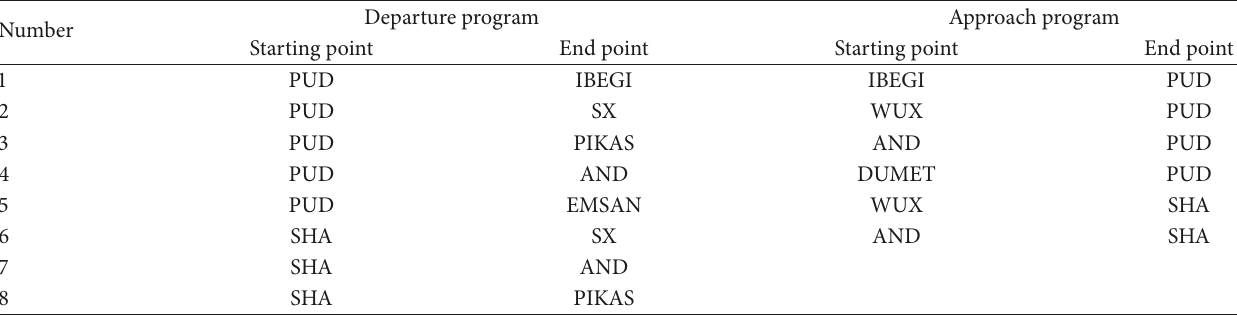
Table 8: Approaching and departure program codes.